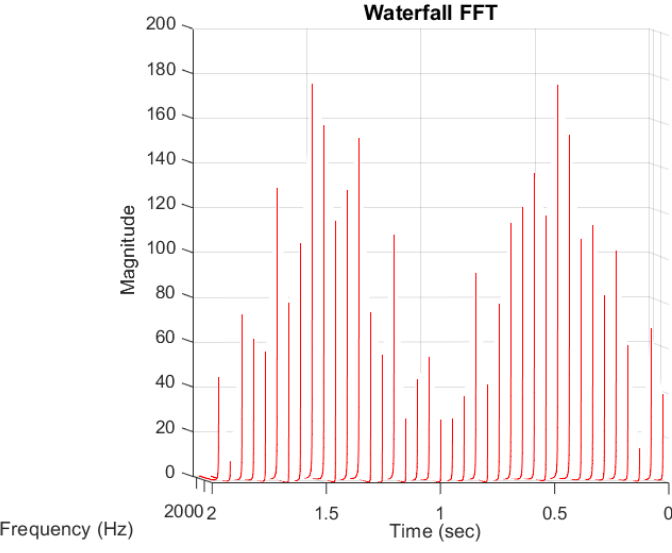
Figure 6. STFT form of the function (9).